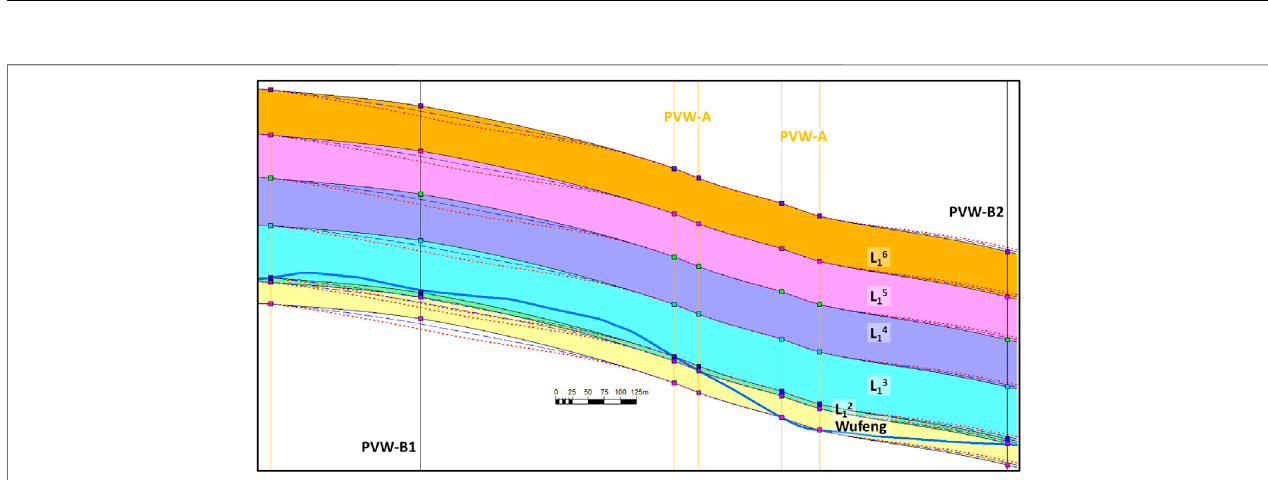
FIGURE13| Theeffect ofcon fi dential constantonthe3D structural model ofshale reservoirs using thecross section alongthewell JY-b. Theblack solidlines, the blue dash lines, and the red dot lines represent the structural model using the con fi dential constant of 95, 85, and 75%.